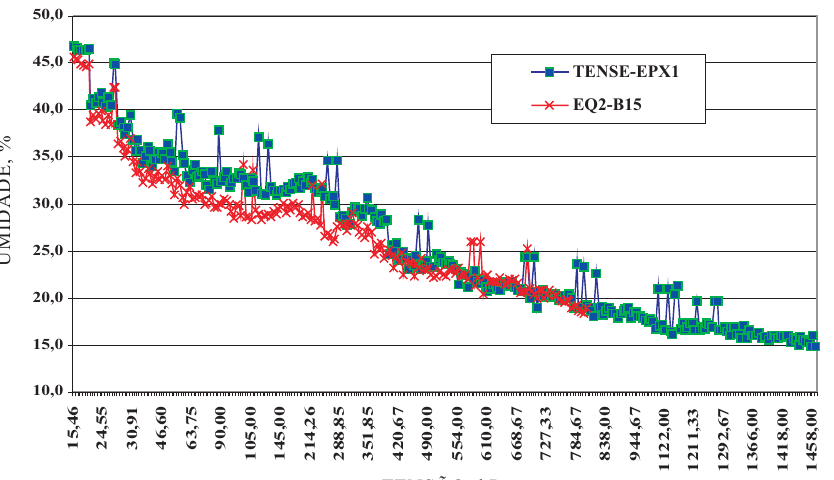
Figura 16. Aspecto da curva característica de retenção de umidade a partir dos dados dos tensiômetros de equivalência e TDR. Diene (2004)